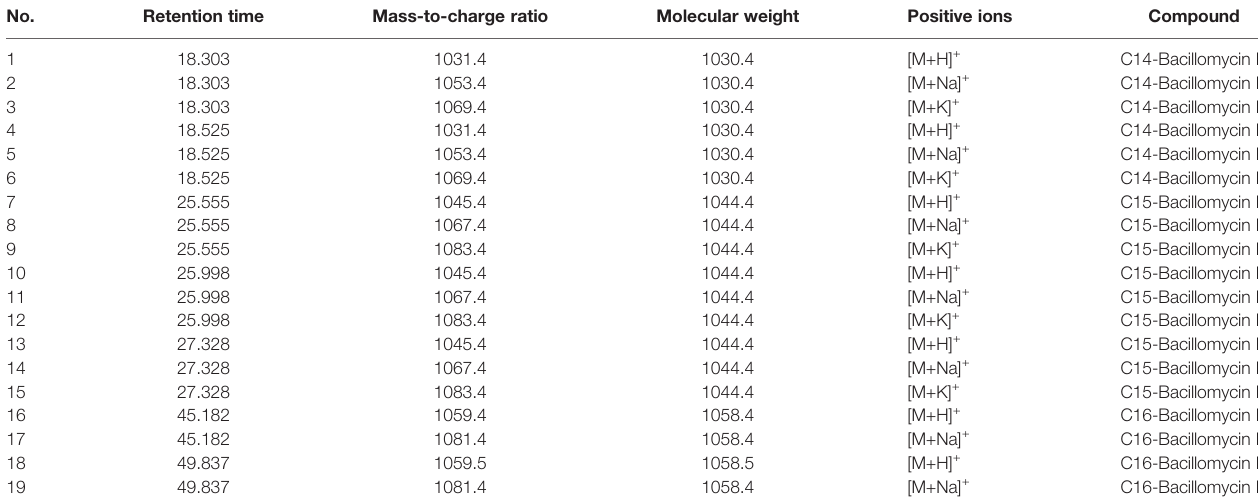
TABLE 2 | Mass peaks of secondary metabolite compounds in n-butanol extract from Bacillus amyloliquefaciens YN201732. No. Retention time